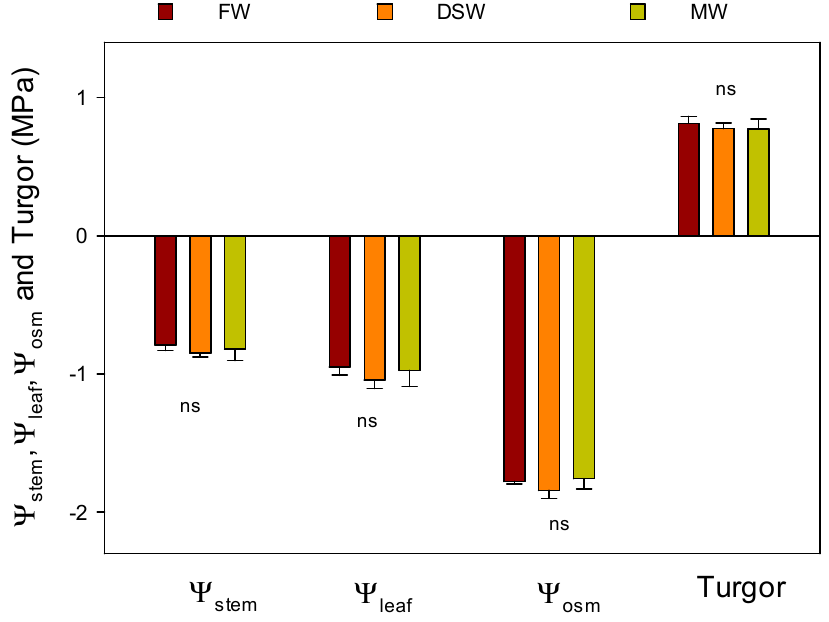
Figure 4. Mean plant water relations and standard deviations ( Ψ stem , stem water potential; Ψ leaf , leaf water potential; Ψ osm , osmotic potential and leaf turgor pressure; expressed in MPa) measured from May 2018 to May 2019 for the three irrigation treatments (fresh water; FW, desalinated sea water; DSW, and mixed water; MW). ns means that significant differences were not detected among treatments for each period (P ≤ 0.05).